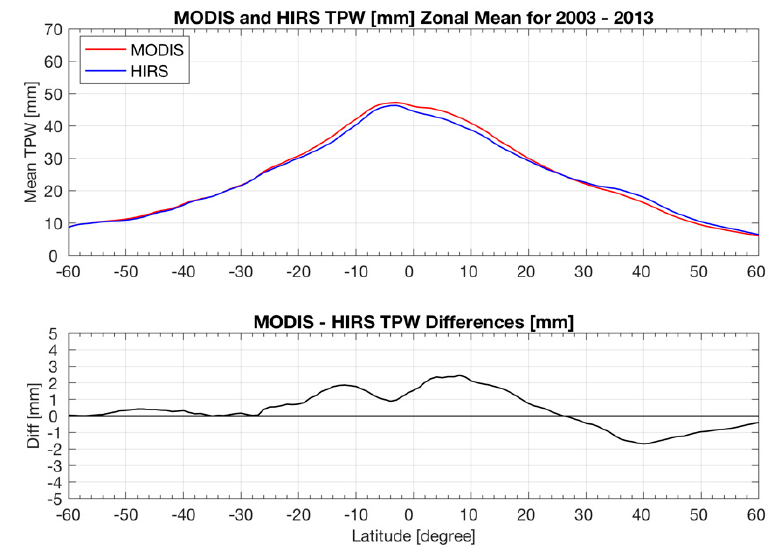
Figure 5. Zonal mean TPW values for MODIS and HIRS ( top ) and their differences ( bottom ) for 1 degree latitude bands.